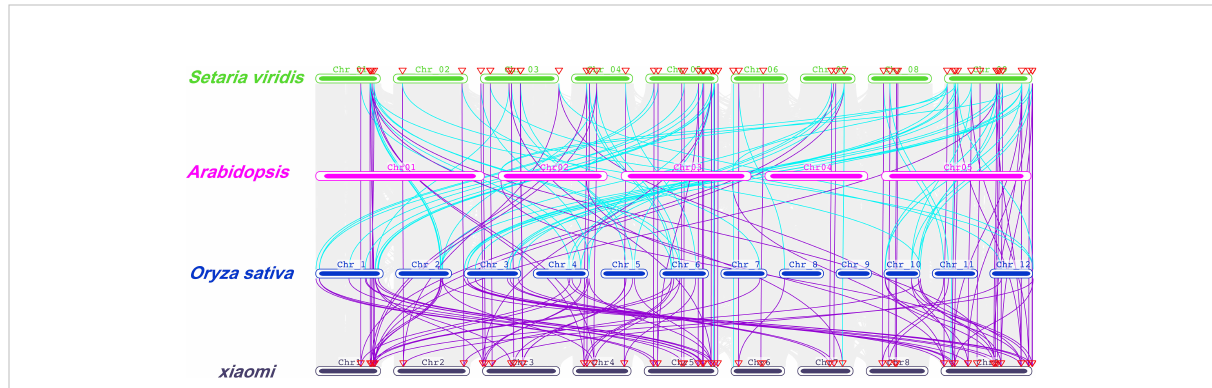
FIGURE 2 Collinearity of the orthologous NPF genes in foxtail millet, green foxtail, rice and Arabidopsis. The genome of each species is shown in one row, and the NPF genes of foxtail millet and green foxtail are shown with different colored lines. The collinear relationship of all orthologous genes in different species was shown with the gray